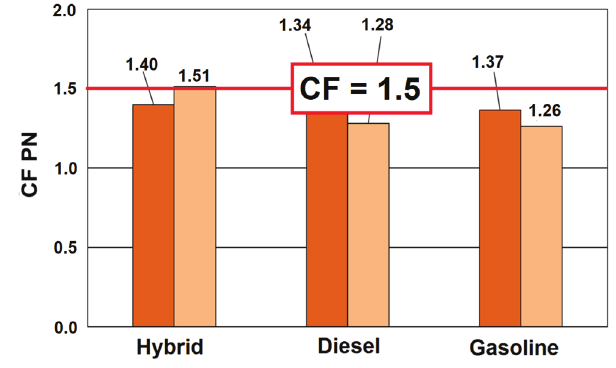
Fig. 19. Particle number emission conformity factor values for each of the vehicles in the whole RDE test (EMROAD and all